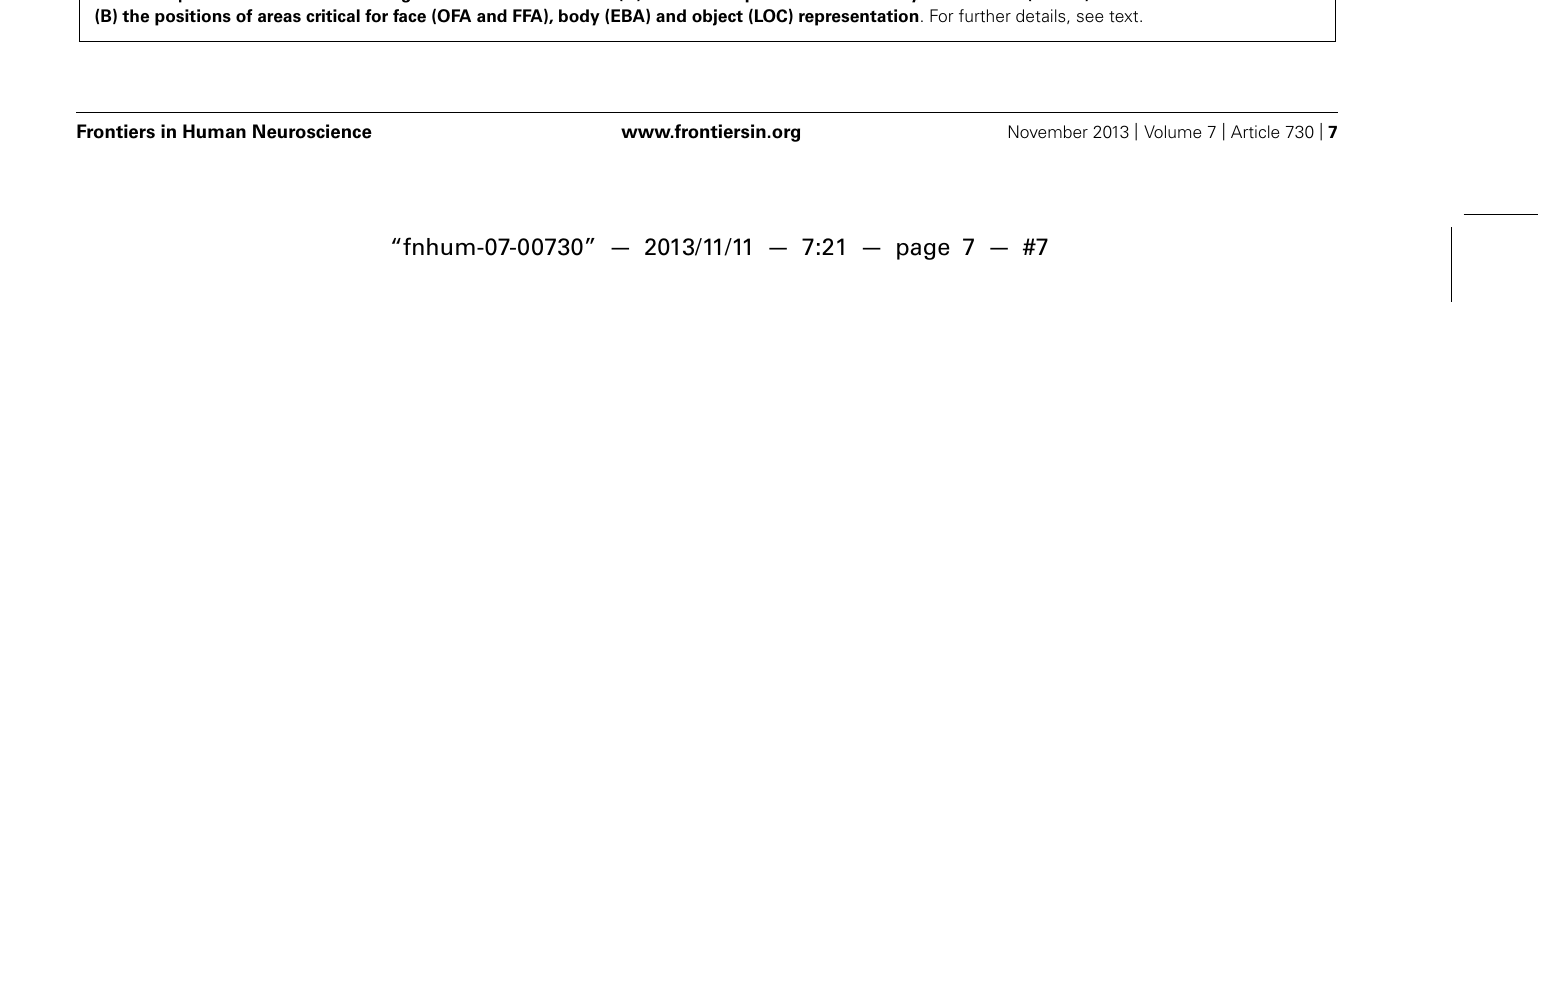
FIGURE 3 | Schematic surface drawings of the brain to indicate (A) the relative positions of the early visual areas (V1–V5) referred to in the text and (B) the positions of areas critical for face (OFA and FFA), body (EBA) and object (LOC) representation . For further details, see text.